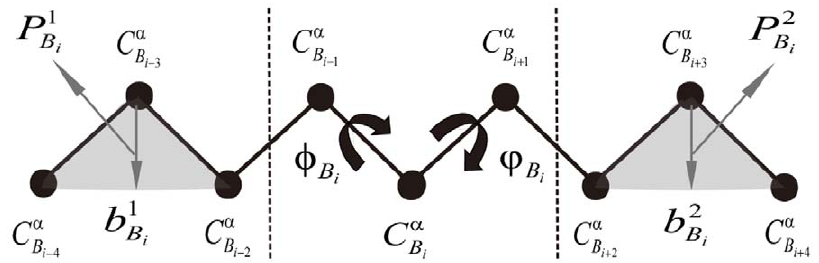
Figure 3. Coarse-grained Structure Model of a 9-residue Fragment. The coarse-grained structure of a 9-residue fragment consists of nine points, each of which represents an amino acid and is denoted as the C a atom of the residue. A link between two C a atoms is a virtual bond that connects the two residues. Thus, the description of the coarse-grained structure of a 9-residue fragment follows that for 3-residue fragment (see , b 2 denote the bisecting vector of C a Figure 2). The bold letters b 1 B i B i , P 2 denote the vectors in a plane defined by three continuous C a atoms ( C a respectively. P 1 B i B i